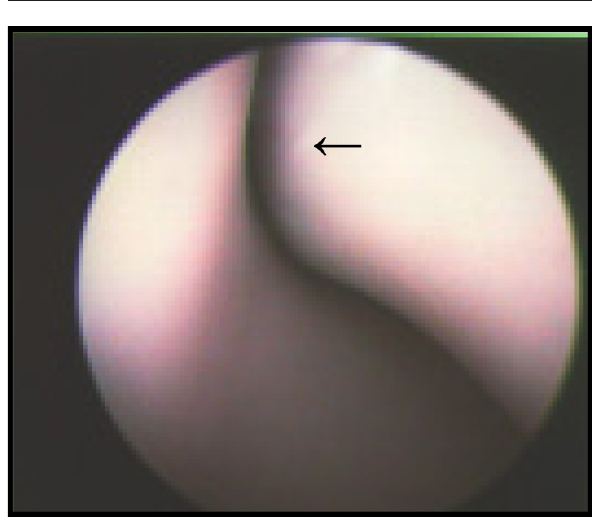
FIGURE 1 - Arthroscopic view of the anconeus process ← ( ) in elbow dog cadaver